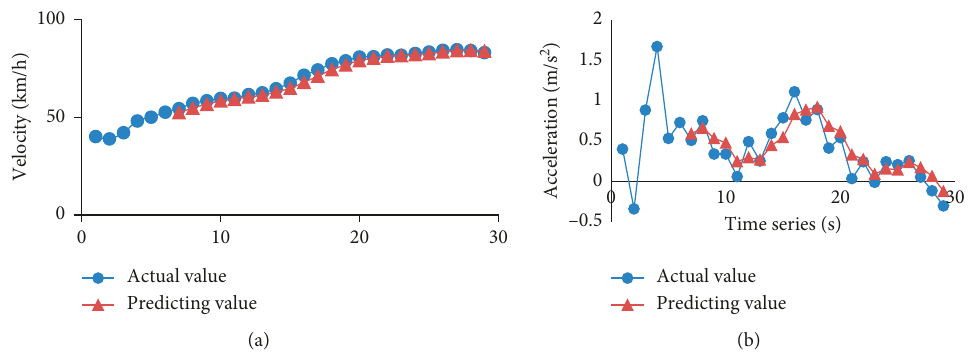
Figure 9: NGSIM trajectory sample prediction results of (a) speed and (b) Table 2: Index table of data prediction and evaluation. Data